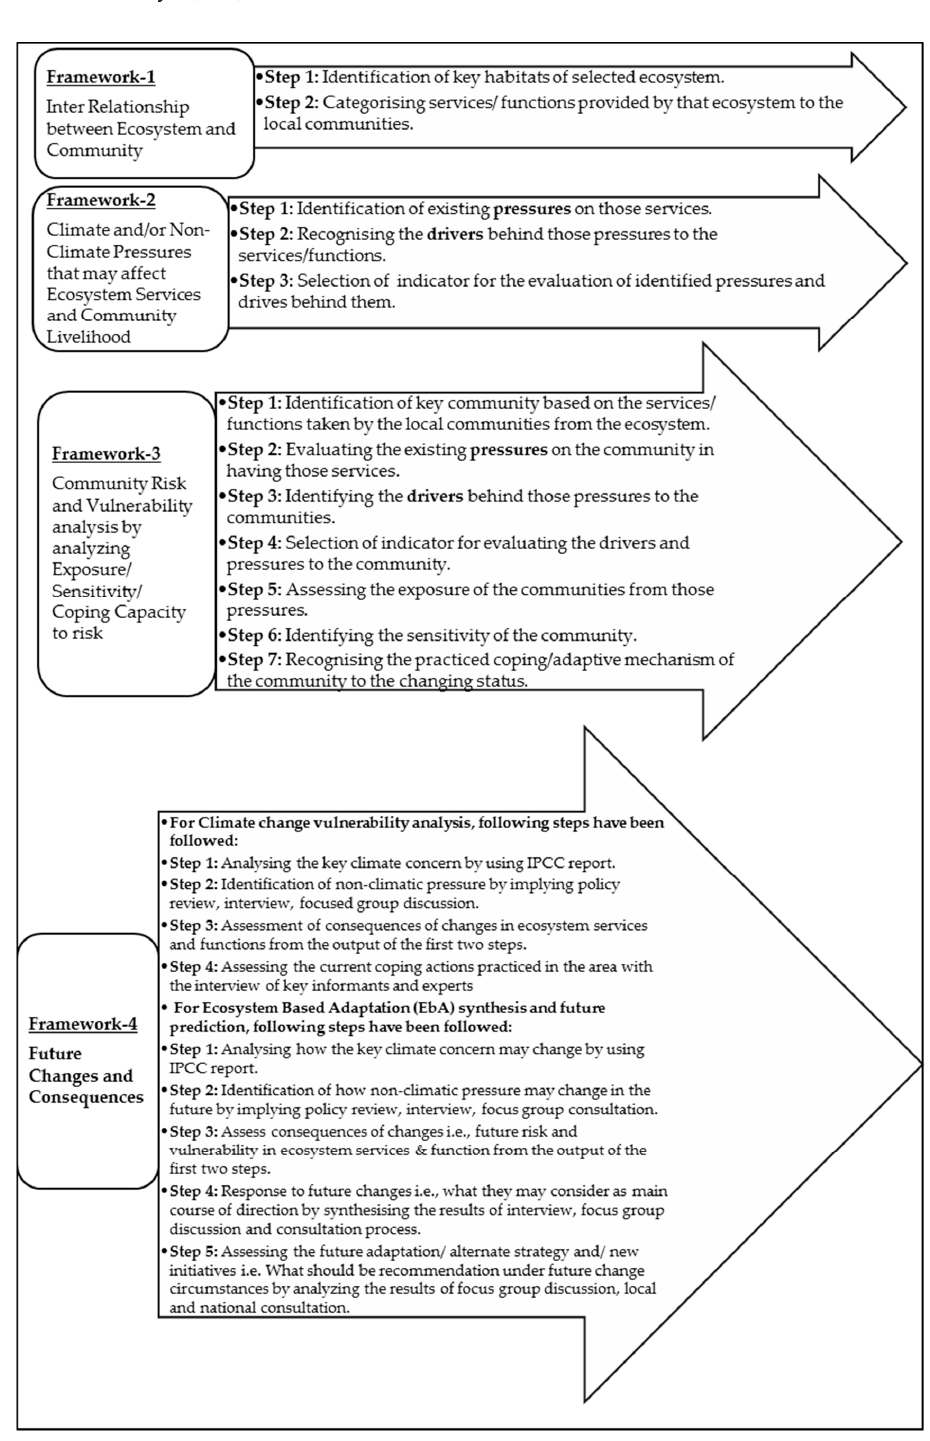
Figure 2. Layout of the DPSIR framework methodology.